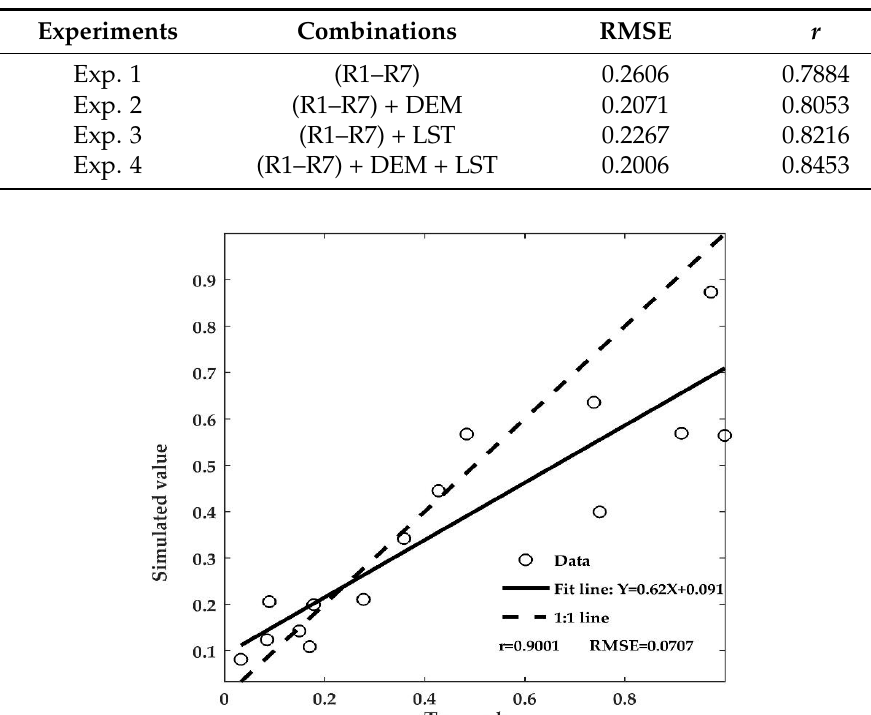
Figure 8. Fitting results of the simulated values of the optimal BP-ANN model versus the true values (UAV FSCs) based on all fifteen samples.